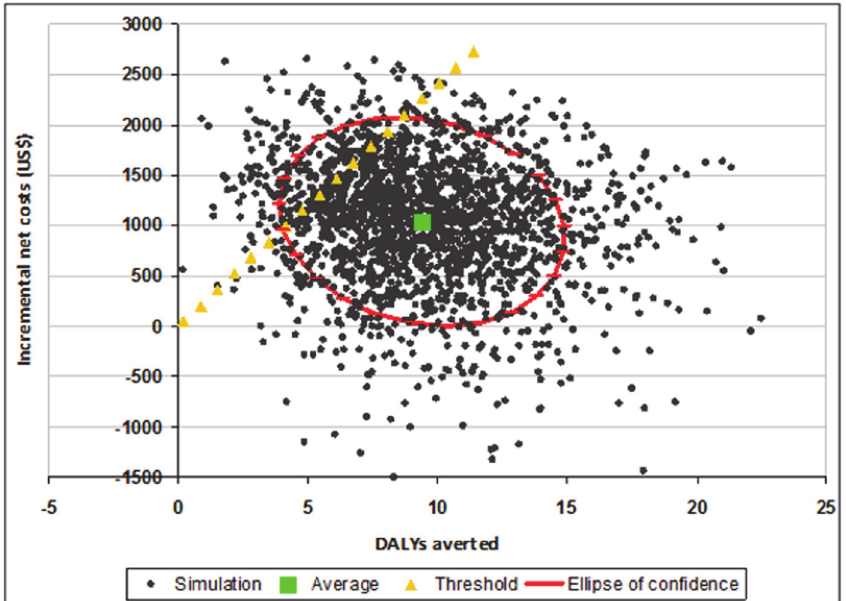
Fig 2. Cost effectiveness plane: IPTp-MQ versus IPTp-SP in HIV-negative pregnant women in Benin, Gabon, Mozambique and Tanzania. IPTp-MQ = Intermittent Preventive Treatment of malaria in pregnancy with Mefloquine; IPTp-SP = Intermittent Preventive Treatment of malaria in pregnancy with Sulphadoxine- Phyrimethamine; HIV = Human Immunodeficiency Virus; DALYs = Disability-adjusted life years. The graph plots 2,000 Monte Carlo simulations of the incremental cost-effectiveness ratio (ICER) with respect to its components: health impact (X-axis) and incremental costs (Y-axis). Average simulation point, ellipse of confidence (95%) and threshold level of the ICER (240 US$/DALY averted) are also depicted. Cost-effective dots are placed below/right the threshold line.